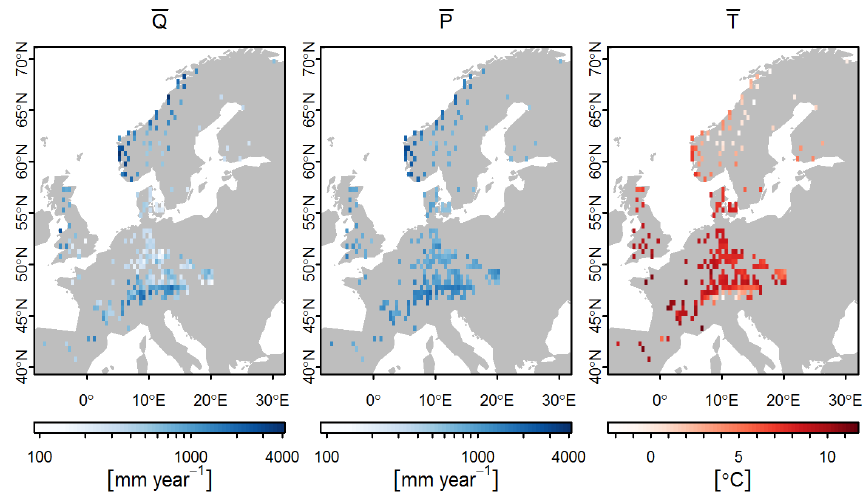
Fig. 1. Mean annual runoff ( ¯ Q ), precipitation ( ¯ P ) and temperature ( ¯ T ) for the period